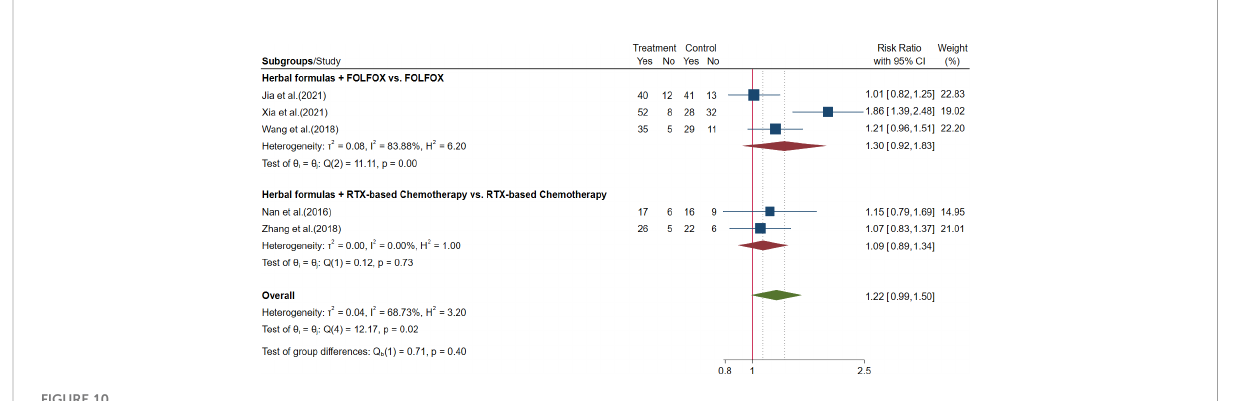
FIGURE 10 Forest plot of disease control rate (DCR) in advanced colorectal cancer